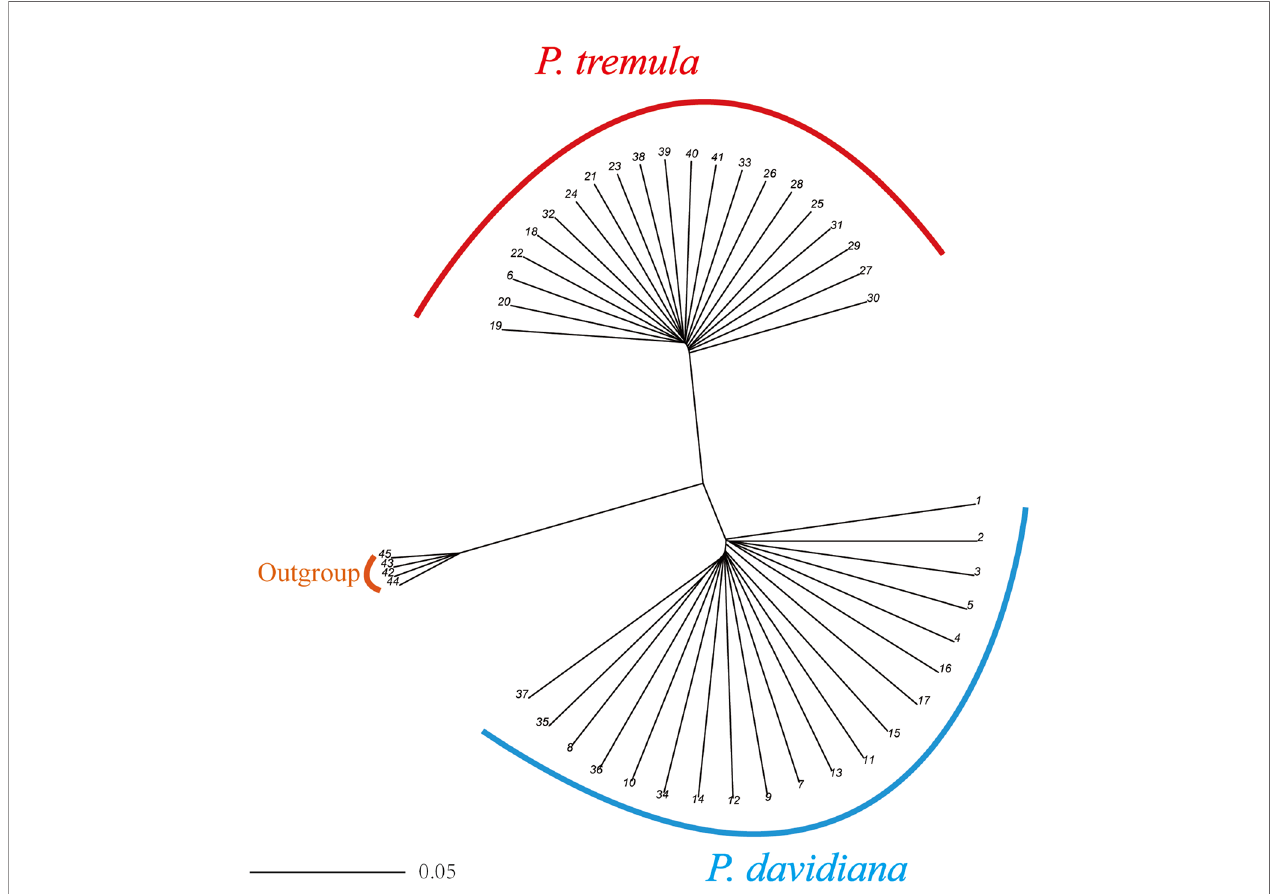
FIGURE 2 | A rooted neighbor-joining tree constructed from the allele-shared matrix of SNPs among the P. davidiana and P. tremula , with the P. tremuloides as an